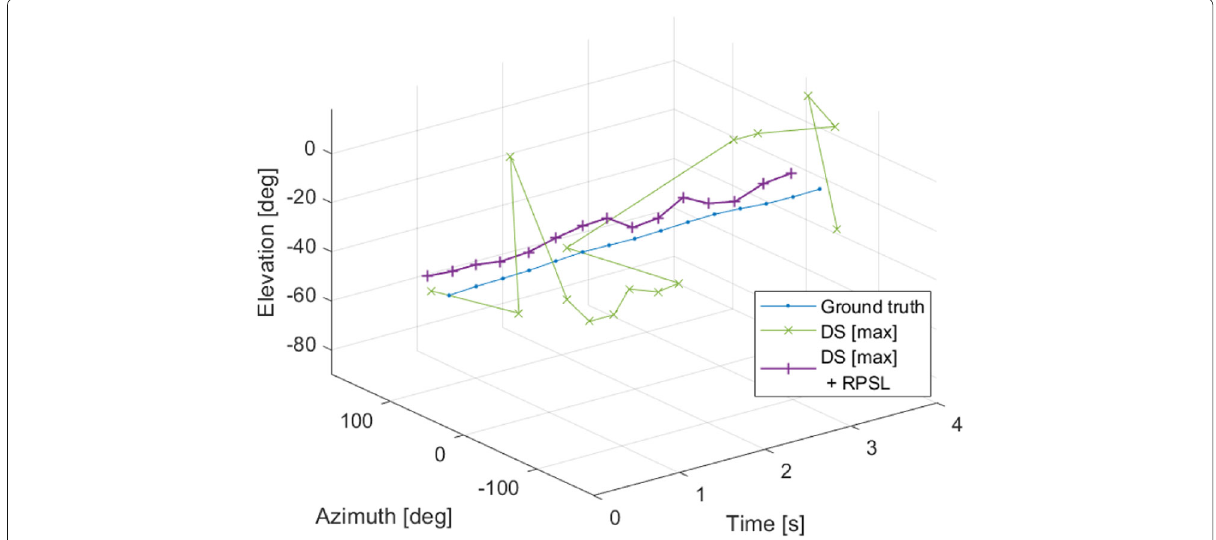
Fig. 16 Example of localisation path estimated for flying UAV speech sound source (task 3) case 3 [1], using the baseline and proposed method (RPSL